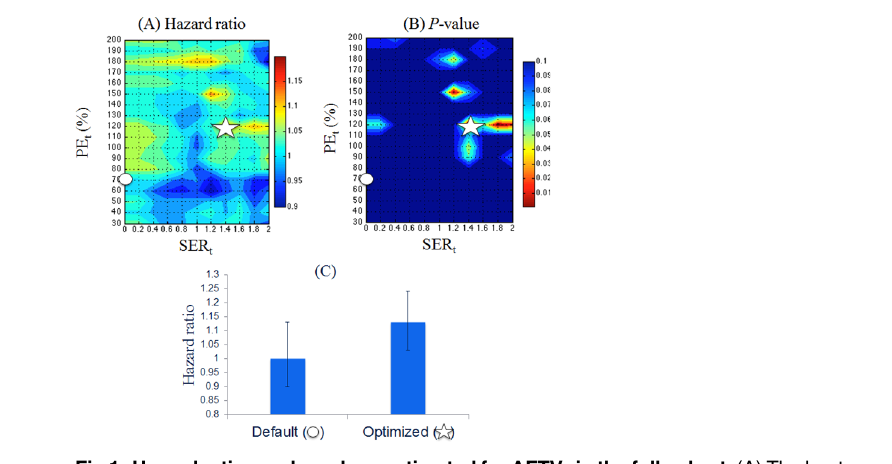
Fig 1. Hazard ratios and p-values estimated for Δ FTV 2 in the full cohort. (A) The heat map of estimated hazard ratios plotted with PE t in the y-axis from 30% to 200% and SER t in the x-axis from 0 to 2. Hazard ratios within the range of 0.9 to 1.2 were color-coded from blue to red. (B) The heat map of p-values, with estimated hazard ratios shown in (A), is shown in the range of 0.001 to 0.1 with color coded from red to blue. Note that values with high hazard ratios and low p-values are coded in red. On both maps, the default setting with PE t = 70% and SER t = 0 was marked as a circle, and the optimized setting at PE t = 120% and SER t = 1.4 was marked as a star. (C) A plot comparing the estimated hazard ratios and confident intervals at default (hazard ratio (H) of 1.0, 95% CI (0.9 – 1.1), p = 0.88) and optimized (hazard ratio (H) of 1.1, 95% CI (1.0 – 1.2), p = 8 × 10 − 4 ) settings.